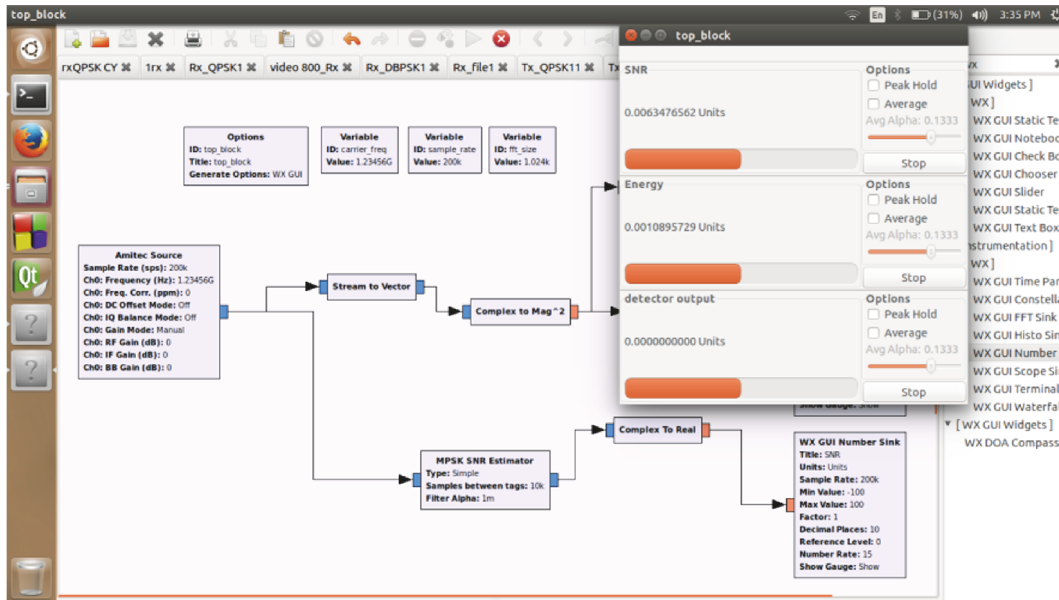
Figure 7: Energy based detector output is zero under only noise no signal condition.